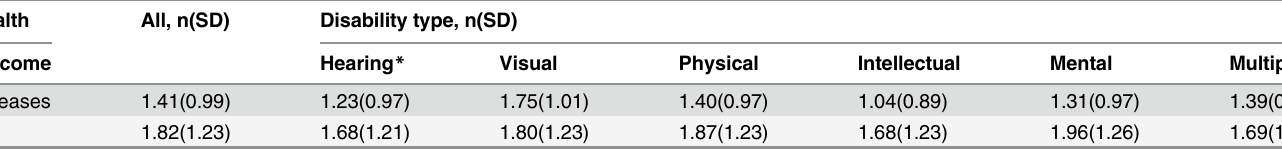
Table 3. Mean number of health conditions among each disability